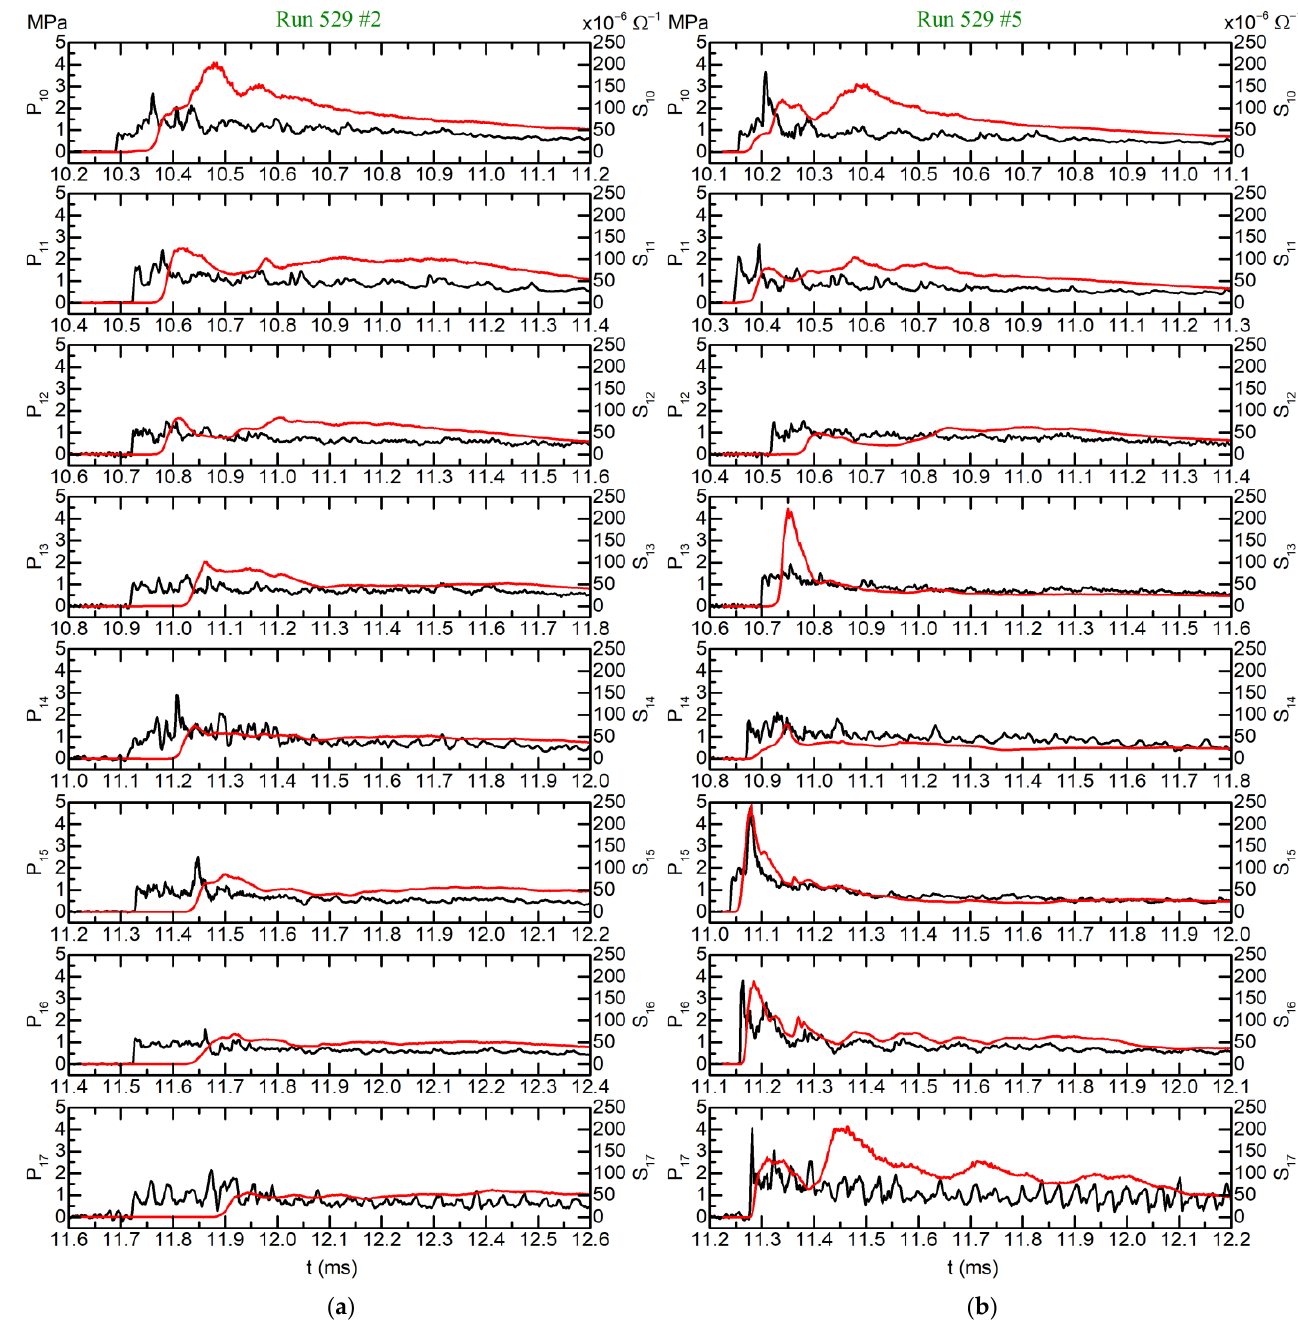
Figure 14. Pressure (black curves, left scale) and conductivity (red curves, right scale) records of pressure and ion sensors installed in measuring ports from 10 to 17 in two experiments: ( a ) 529#2 and ( b ) 529#5 with the same stoichiometric methane–hydrogen–air mixture at normal initial conditions. Conductivity plots are obtained by processing voltage signals from ion sensors. Fuel: 65%vol. methane + 35%vol. hydrogen. Time is counted from ignition triggering.